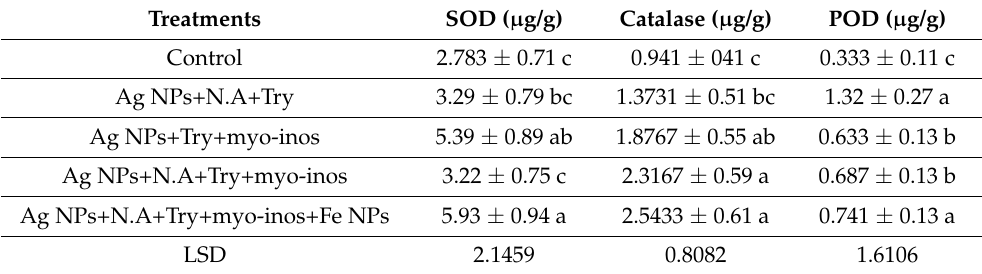
Table 4. Effect of different treatments of blended NPs on antioxidant enzyme activities of wheat.